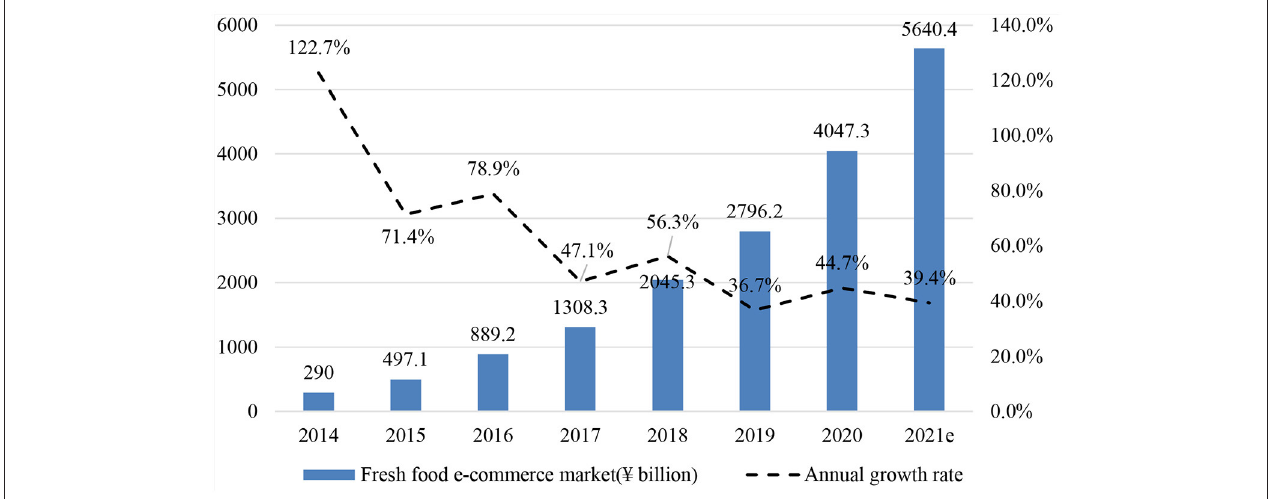
terms of consumer activities, Zhang and Mu (2018)